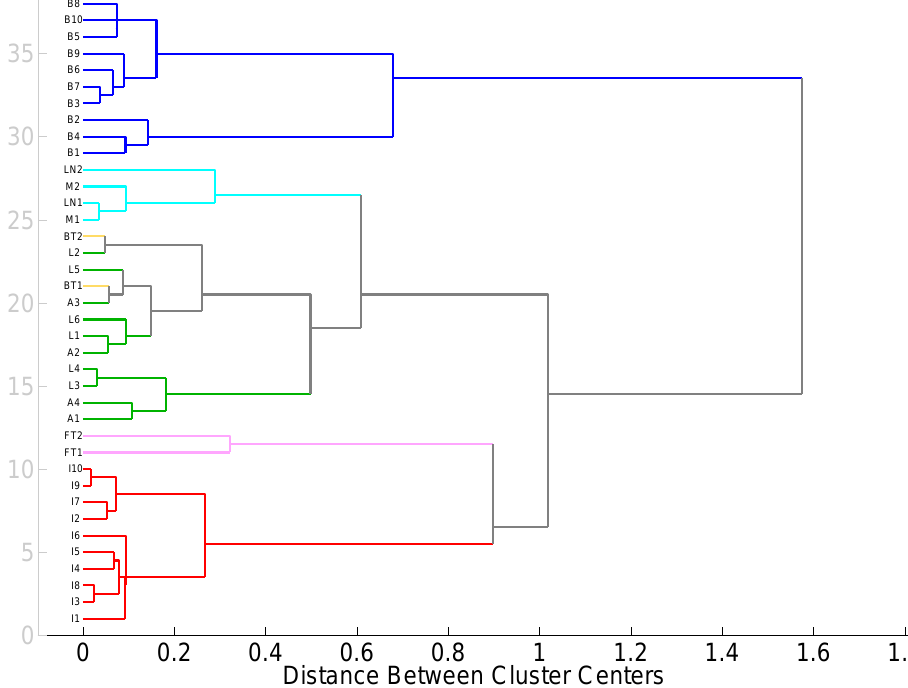
Figure 5. Dendrogram showing the grouping relationship between the various gas-phase matrices of systems examined. Red – isoprene, pink – fig, green – cyclic monoterpenes ( α -pinene and limonene), yellow – birch, light-blue – straight chain monoterpenes (myrcene and linalool) and dark-blue – sesquiterpene ( β